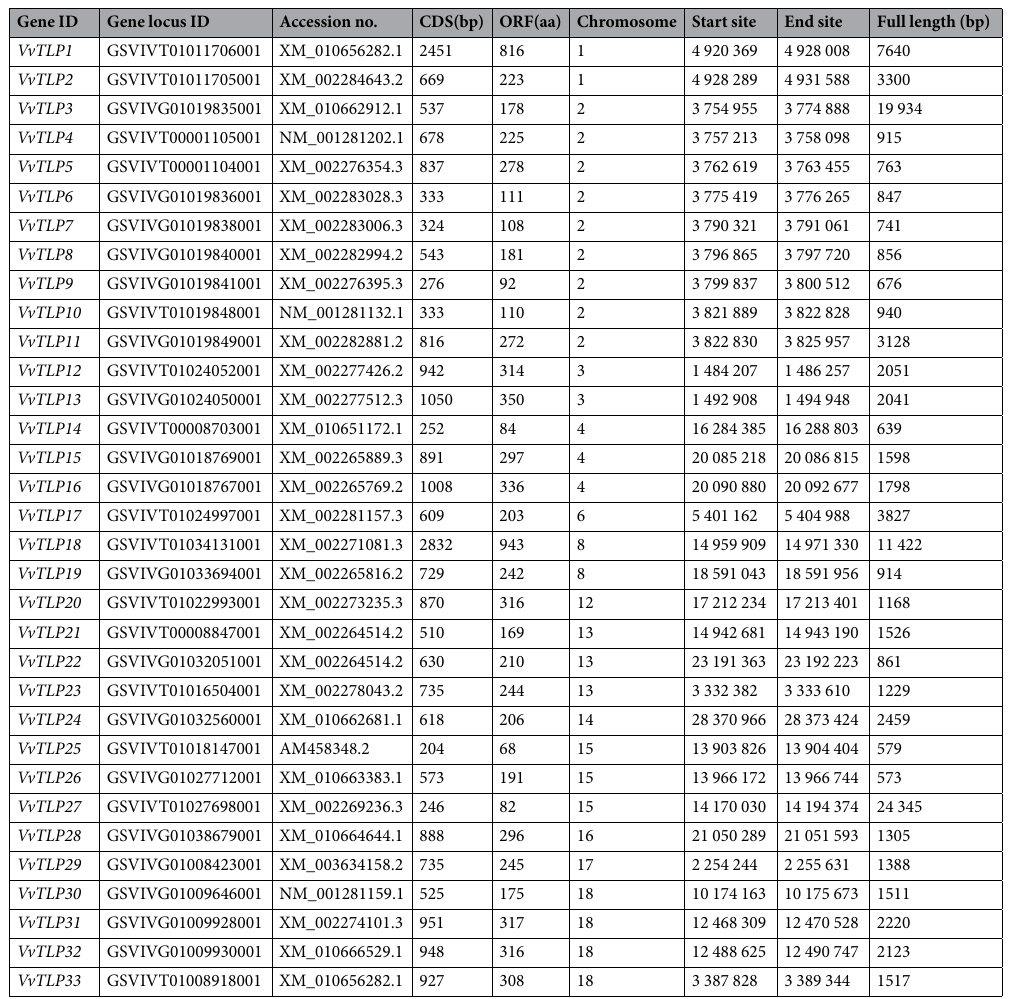
Table 1. Grape TLP genes and accession numbers. CDS: coding sequence, ORF: open reading